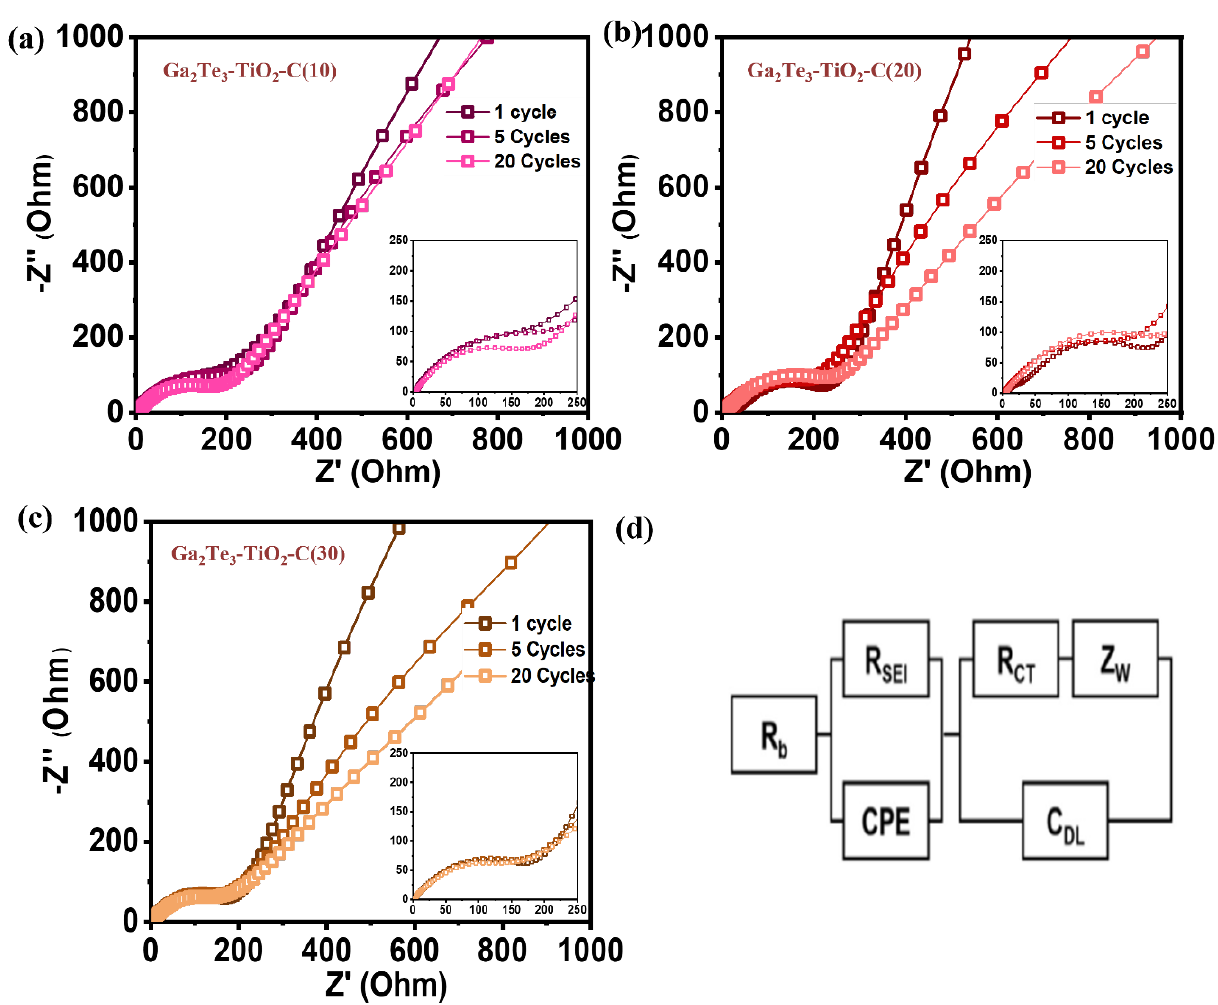
Figure 5. EIS-based Nyquist plots for ( a ) Ga 2 Te 3 – TiO 2 – C(10%), ( b ) Ga 2 Te 3 – TiO 2 – C(20%), and ( c ) Ga 2 Te 3 – TiO 2 – C(30%) after one, five, and 20 cycles; ( d ) equivalent circuit.